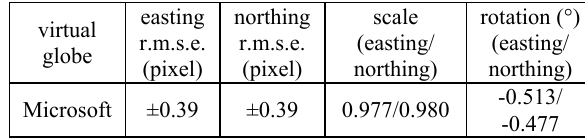
Table 3. Comparison of map geometry (Mercator projection) of Microsoft Bing Maps with Gauss-Krüger projection (M28).